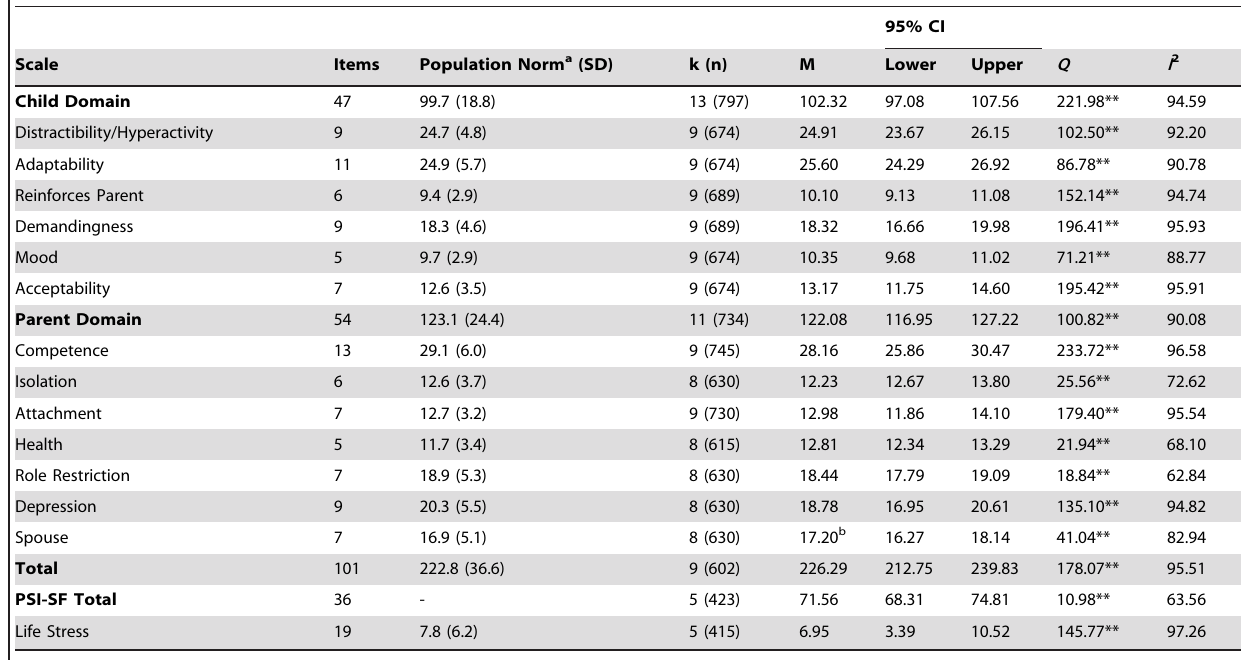
Table 4. Meta-Analytic Results of Parents’ Mean PSI Scores.